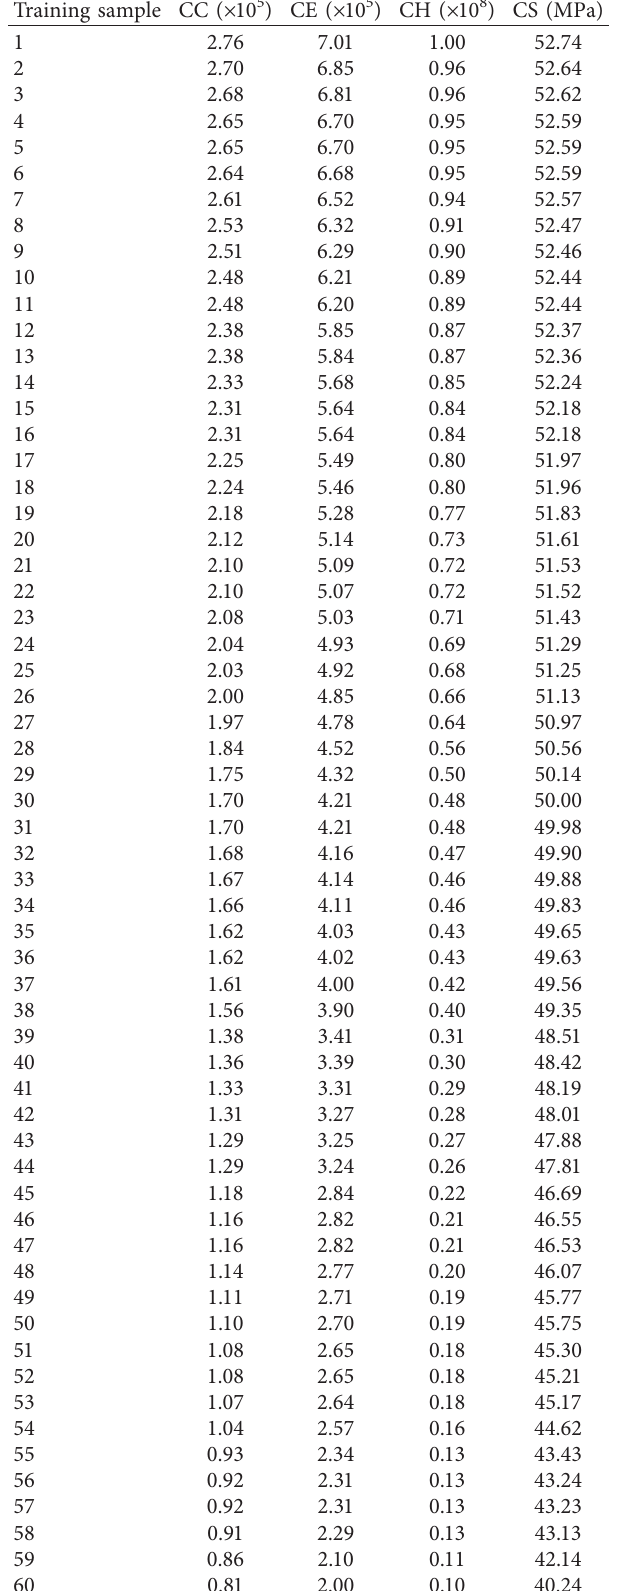
Table 3: Training and testing